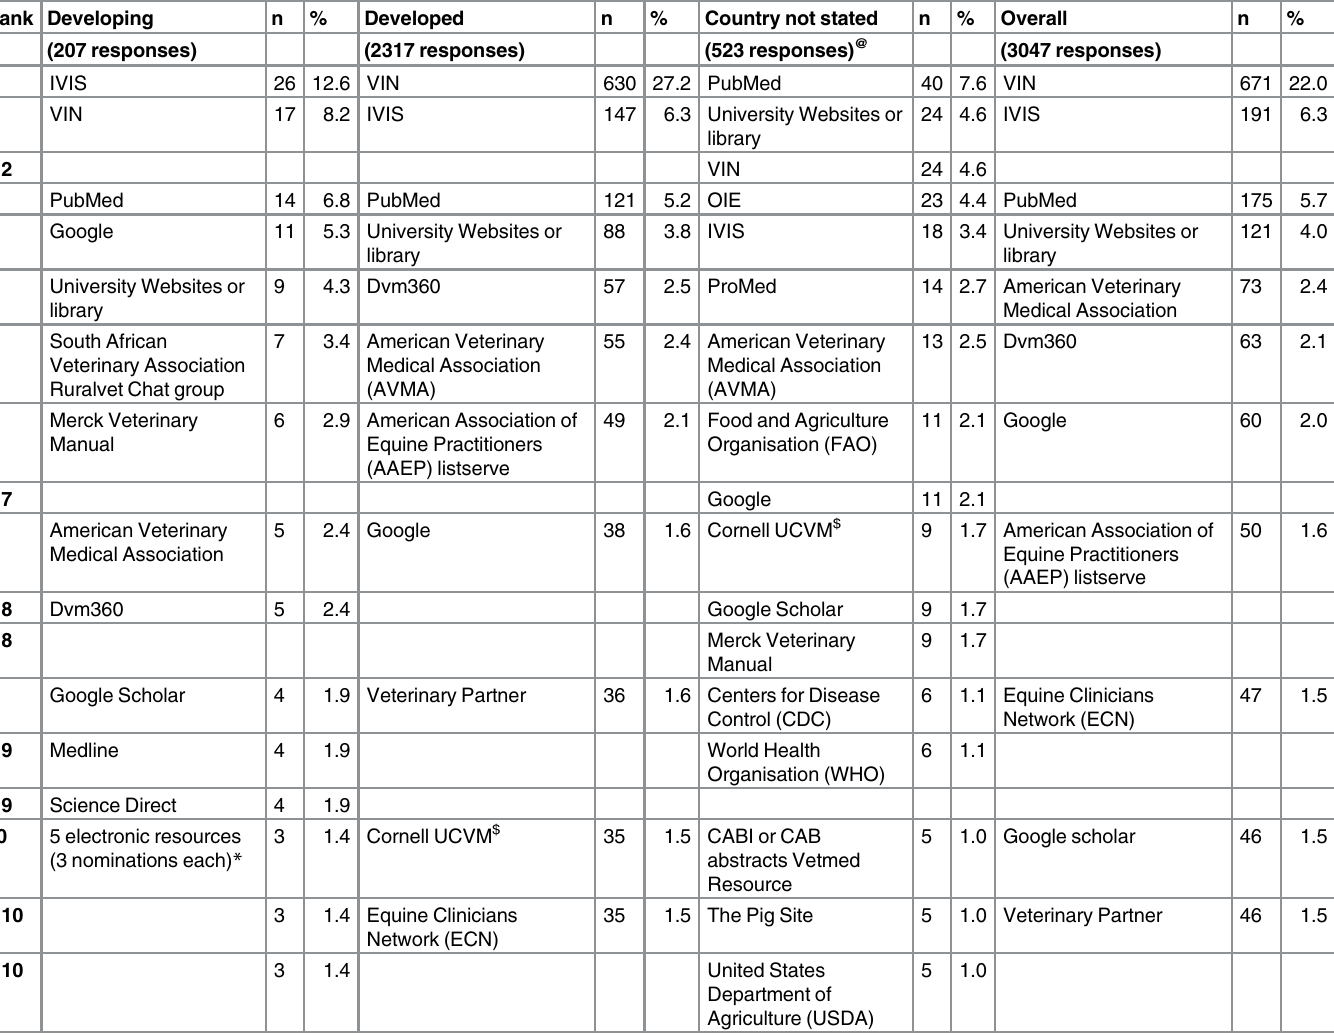
Table 6. Table of the top ten electronic resources most accessed as nominated as by respondents working in developing and developed coun- tries. Respondents could nominate up to 10 electronic